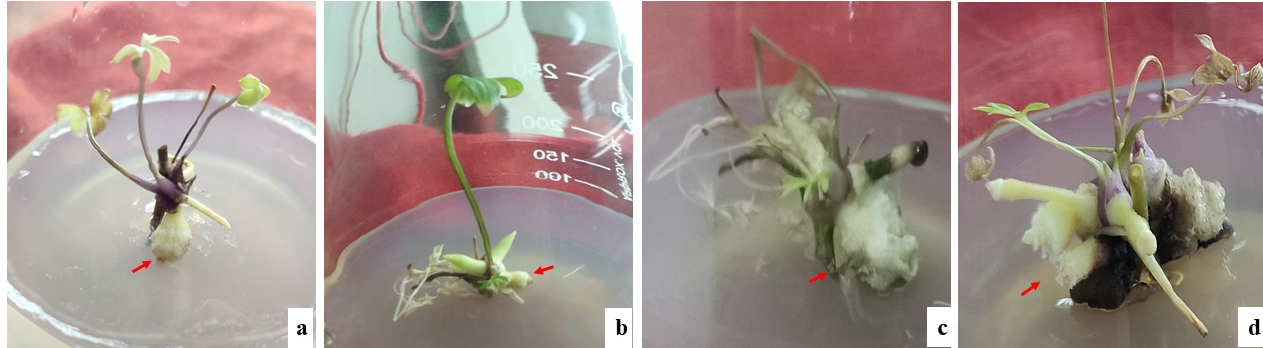
The data were recorded for up to 10 weeks. The data represent the mean value ± SEM (standard error mean) and were found to be statistically operative and significant according to Duncan’s multiple range test (DMRT) at p ≤ 0.05. Mean ± SEM followed by the different letters within each column are significantly different according to DMRT (one-way ANOVA) at p ≤ 0.05.